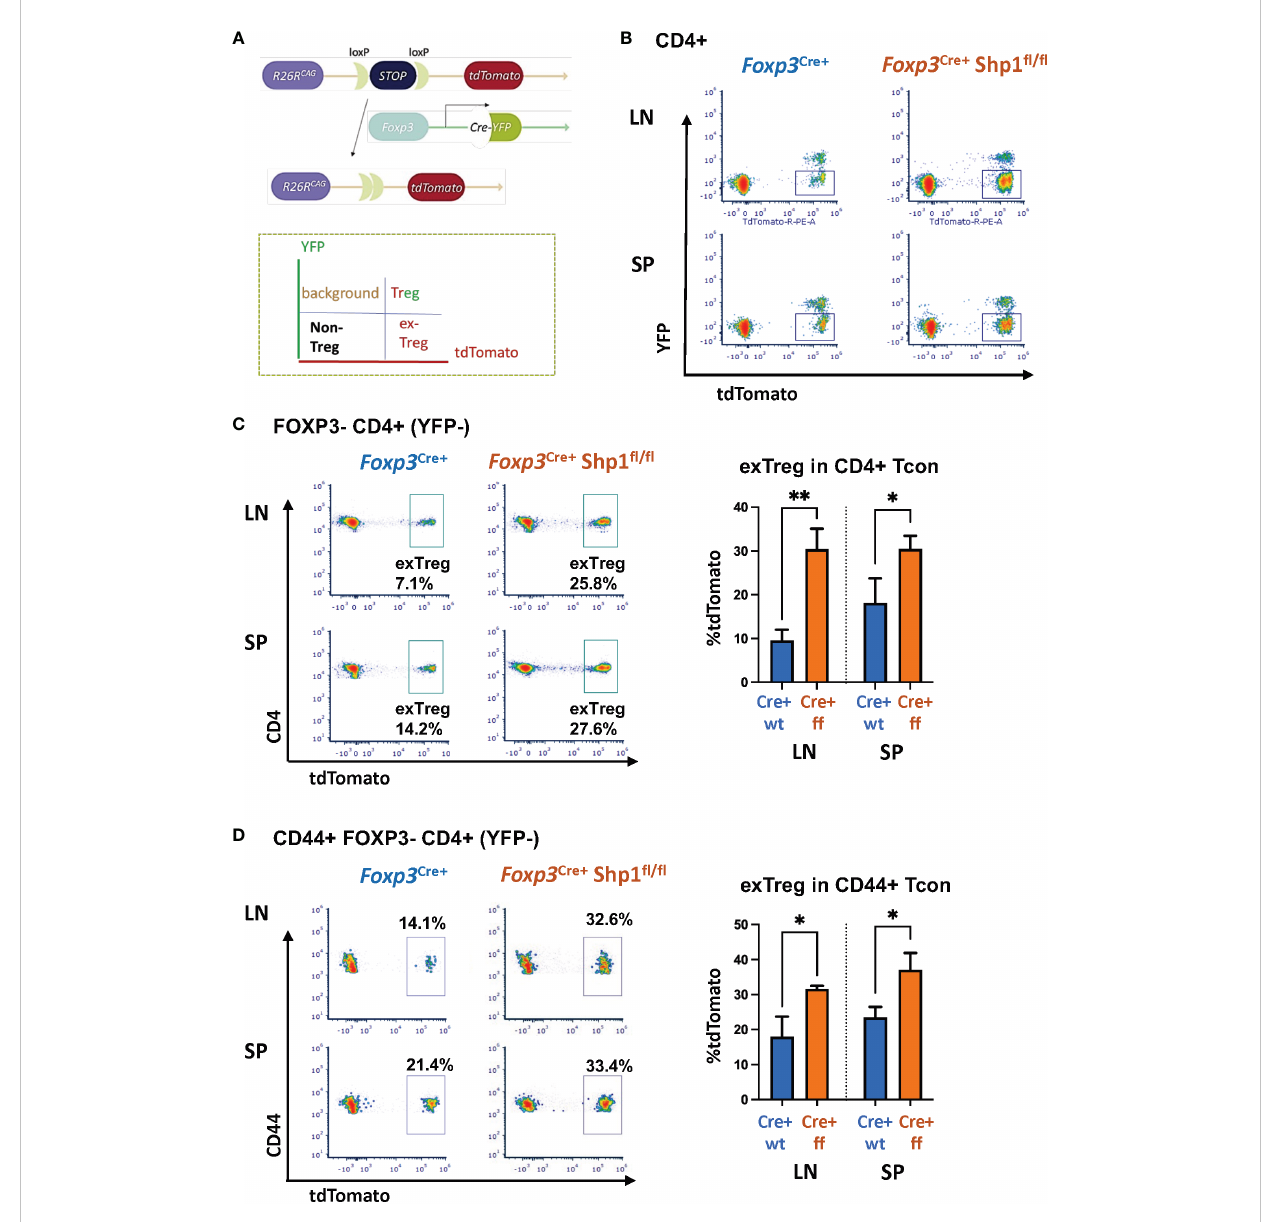
FIGURE 5 SHP-1 promotes Treg cell lineage stability . (A) Schematic diagram and (B) fl ow cytometry representation of Treg lineage tracing model. Gates for tdTomato+ YFP- (exTreg) cells are indicated throughout the panels. tdTomato (cre-inducible expression) were crossed with Foxp3 YFP-cre / Shp-1 f/f and Foxp3 YFP-cre control mice. (C , D) Plot depicts T cell subpopulations based on YFP and tdTomato expression. Flow cytometric analyses of (C) tdTomato+ (exTreg) within CD4+ FOXP3 (YFP)- Tcon (LN p-value =0.0023, SP p-value = 0.0449) and (D) tdTomato+ (exTreg) within CD44 +FOXP3-CD4+ T cells in 8 weeks old mice (LN p-value = 0.0146, SP p-value = 0.0388). Percentages of exTreg cells within each subpopulation are indicated. Gated: (B) singlets ! live ! CD4 (C) singlets ! live ! CD4 ! FOXP3-(YFP-) (D) singlets ! live ! CD4 ! FOXP3-(YFP-) ! CD44. Data are from 2 experiments with each 2-3 mice per genotype. *, p<0.05, **,